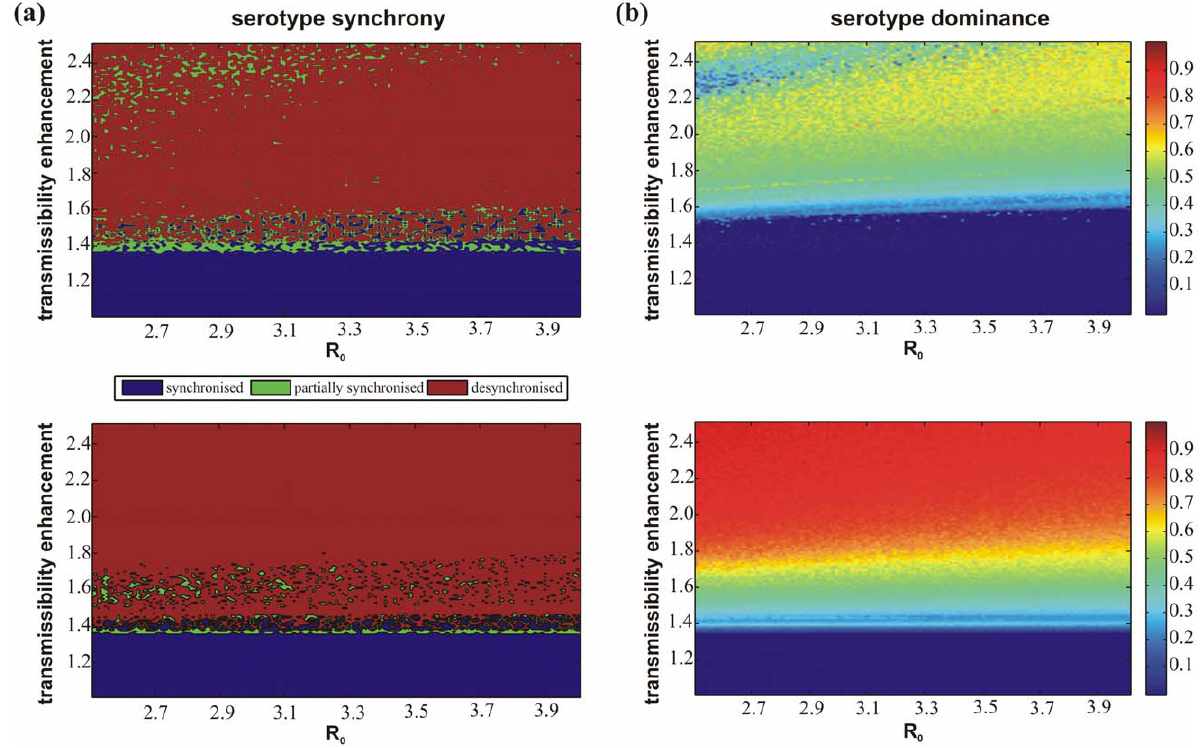
Figure 3. Comparison of synchronisation and single-serotype dominance between model (i) ( top ) and model (ii) ( bottom ). (a) The synchronisation pattern between serotypes 1 and 2 indicates that, for both models, most of parameter space is characterised by desynchronised behaviour i.e. the dynamics of the two serotypes are not ‘locked’ together. (b) Using a measure of single serotype dominance (where 0 corresponds to at least two serotypes being simultaneously dominant and higher values indicate a greater tendency for one serotype to be dominating at any given time), one can observe that in both models the trend is for increasing levels of dominance with increasing enhancement; this trend is more pronounced in model (ii) than model (i).